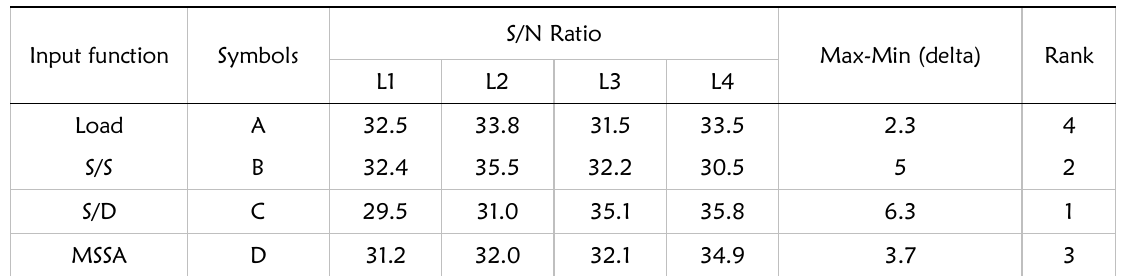
Table 4: Analysis of SN ratio for wear rate